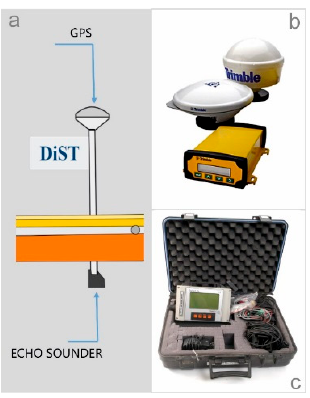
Figure 5. ( a ) Installation positions of the GPS and echo sounder on drone; ( b ) Trimble DSM232 GPS; ( c ) Omex Sonarlite echo sounder.